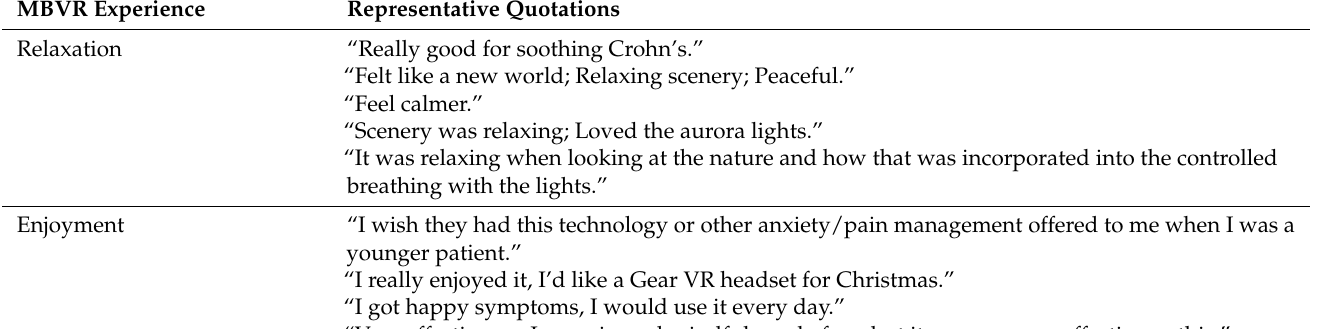
Table 1. Qualitative feedback: A selection of responses about participants’ MBVR experience and areas for future use. MBVR